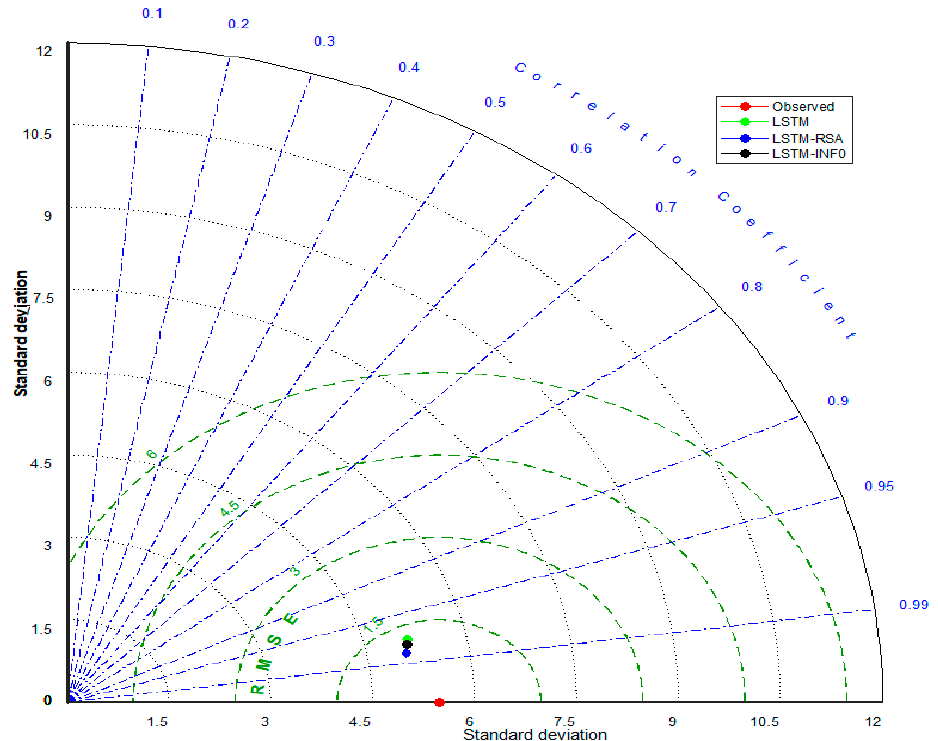
Figure 8. Taylor diagrams of the predicted water temperature using different LSTM-based models in the test period with the best input combination.